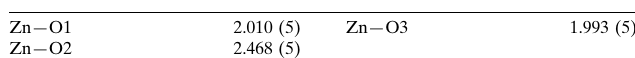
Selected bond lengths (A˚ ).